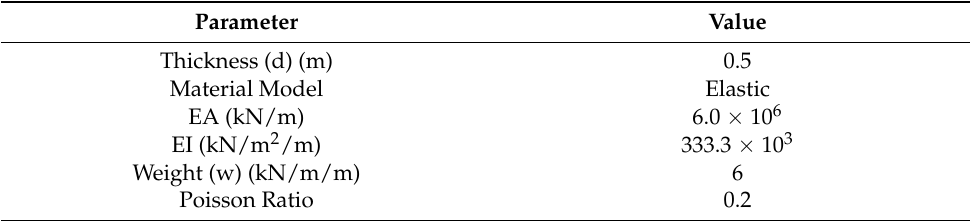
Table 4. Properties of raft foundation as plate element (data from Ref. [69]).